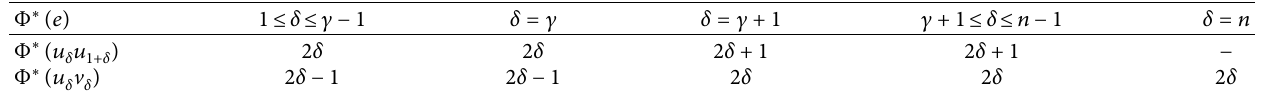
Table 30: Edge labeling of Φ ∗ ( e )